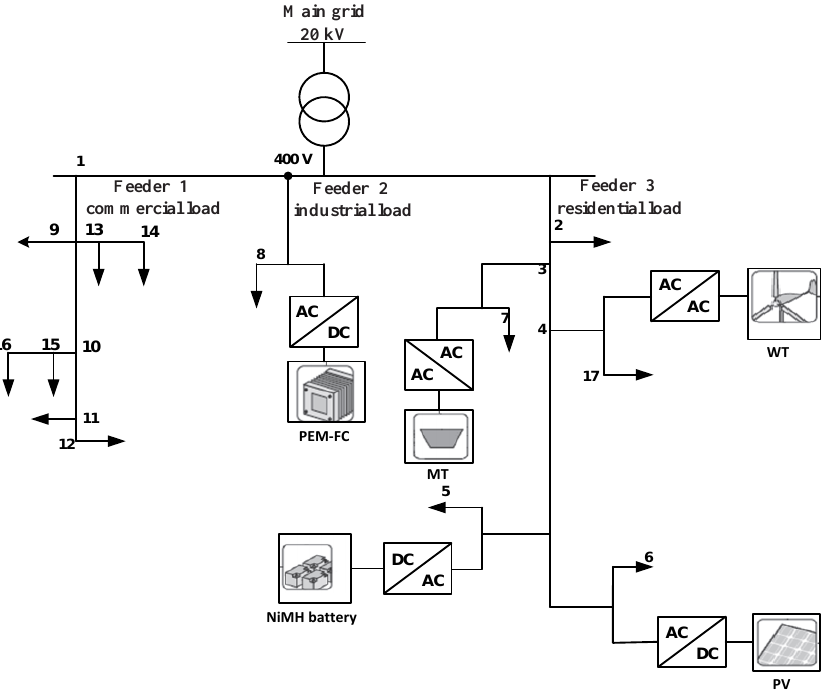
Figure 1. One-line diagram of a standard micro-grid (MG) test system.